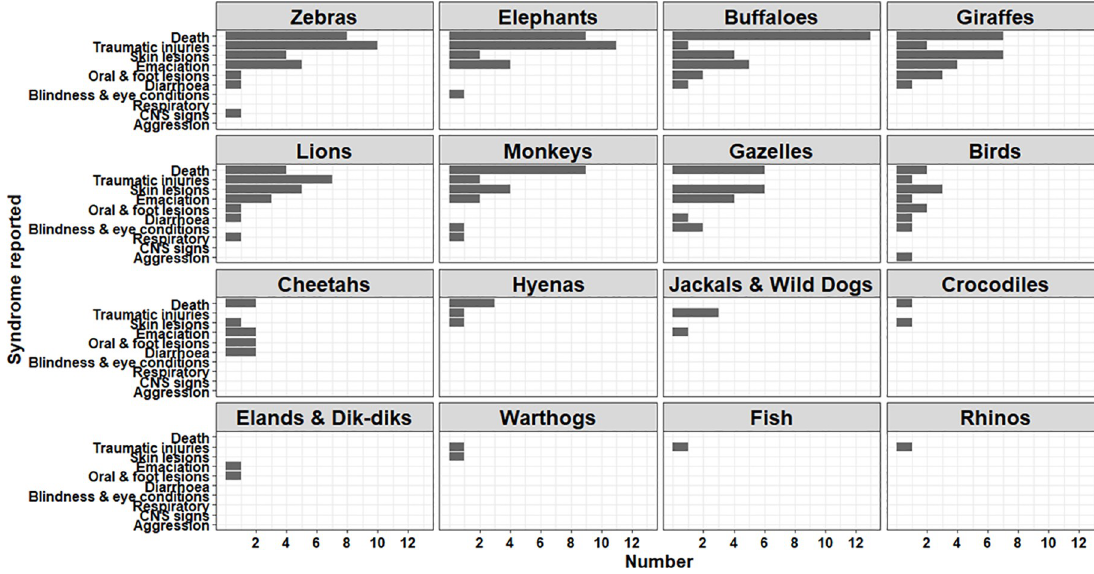
Fig 5. Trends in disease syndromes reported in wildlife in Kenya using the KABS mobile phone application, (2017–2019).